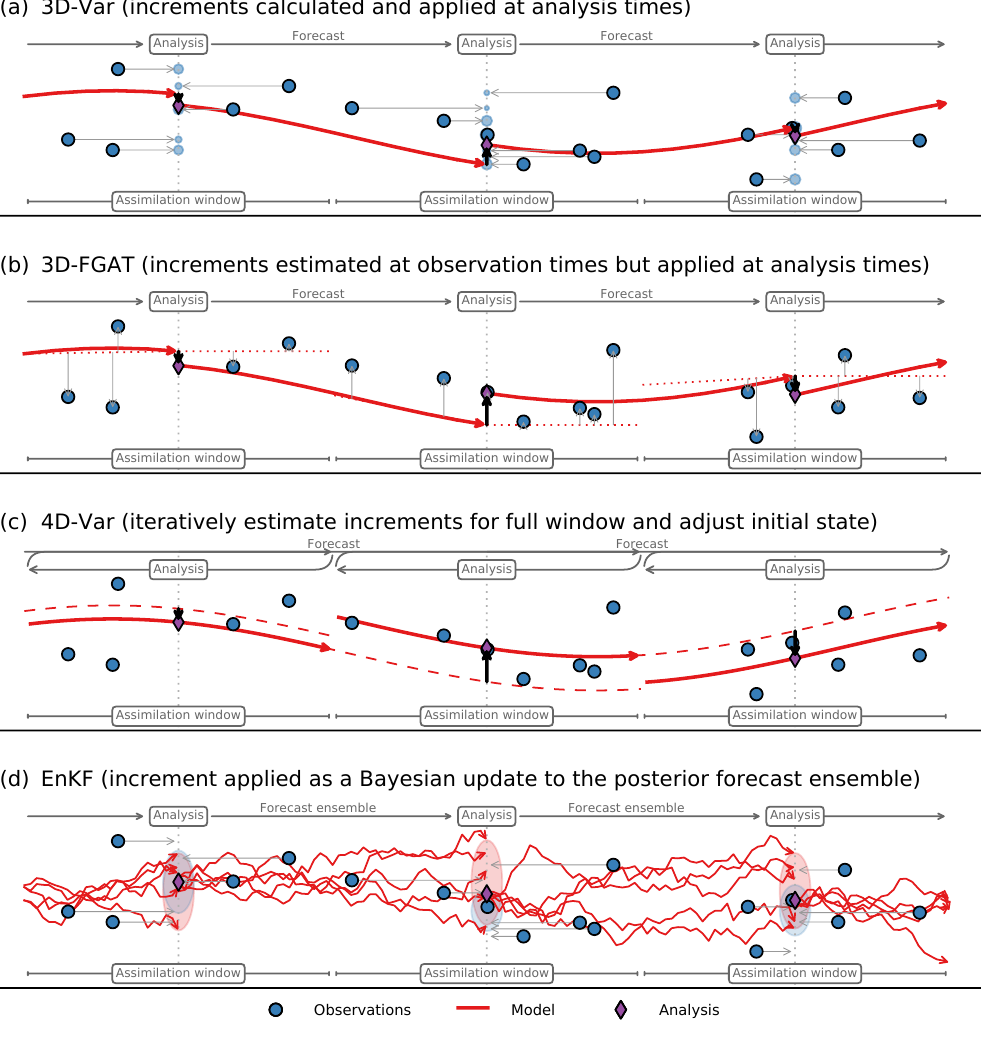
Figure 5. Simplified schematic representations of four data assimilation strategies used by current reanalyses: (a) 3D-Var, (b) 3D-FGAT, (c) incremental 4D-Var, and (d) EnKF. Blue circles represent observations, red lines represent model trajectories, and purple diamonds indicate analyses. The dotted red lines in (b) represent linearly interpolated or extrapolated forecast values used to estimate increments at observation times. The dashed red lines in (c) represent the initial forecast, prior to iterative adjustments. These illustrations are conceptual and do not accurately reflect the much more complex strategies used by reanalysis